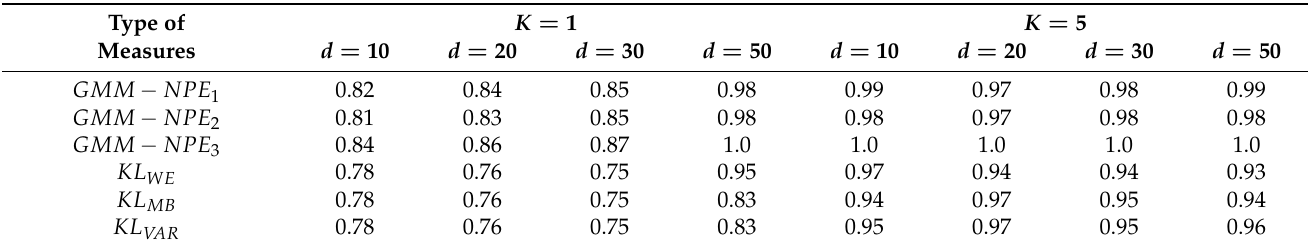
Table 5. Results in the form of recognition accuracy, obtained on the synthetic data: l = 2, t 1 , t 2 ∈ [ − 3,5 ] , N = 800, M = 200, m 1 , m 2 = 0.